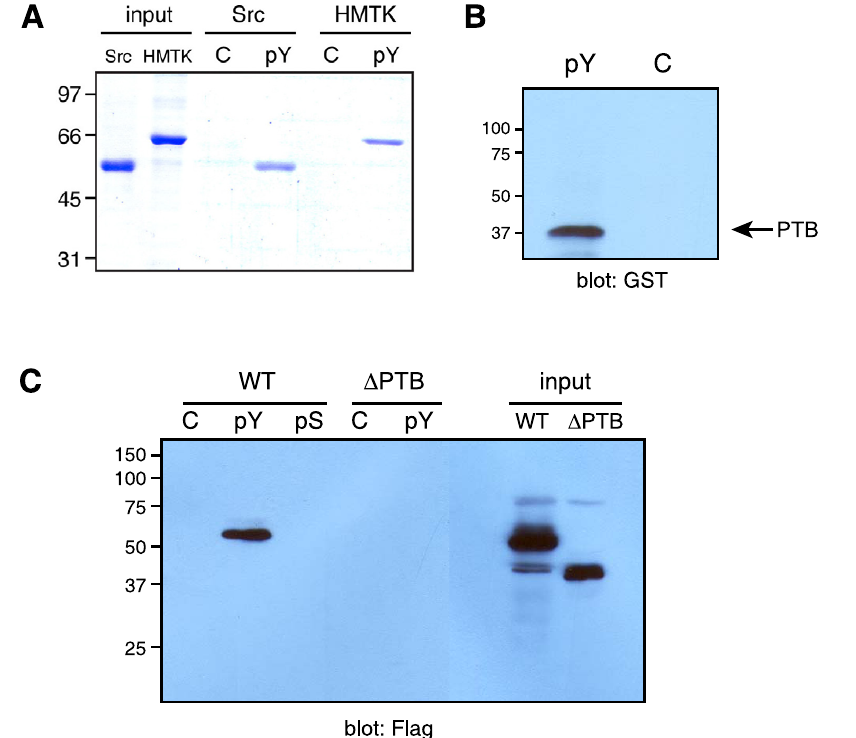
Figure 3. Binding reactions with pYEEI-containing peptide. (A). Purified HMTK1 or c-Src (20 m g) were mixed with 30 m l of immobilized pYEEI peptide (pY) or control resin (C) in total volumes of 175 m l for 1 hour at 4 u C. After binding, the resins were washed 4 times with 200 m l of binding buffer. Bound proteins were eluted with SDS-PAGE sample buffer and analyzed by gel electrophoresis with Coomassie blue staining. (B). The isolated HMTK1 PTB domain (8 m g) was incubated with 50 m l of immobilized pYEEI peptide (pY) or control resin (C) in total volumes of 400 m l for 1 hour at 4 u C. After washing, bound proteins were eluted with SDS-PAGE sample buffer and analyzed by Western blotting with anti-GST antibody. (C). Lysates from SYF cells expressing FLAG-tagged wild-type or D PTB forms of HMTK1 were incubated with immobilized pYEEI peptide (pY), phospho-Kemptide (pS), or control resin. After washing, bound proteins were analyzed by anti-FLAG Western blotting. The input lanes show lysates (corresponding to 20% of the amounts used for pulldowns) loaded directly on the gel.